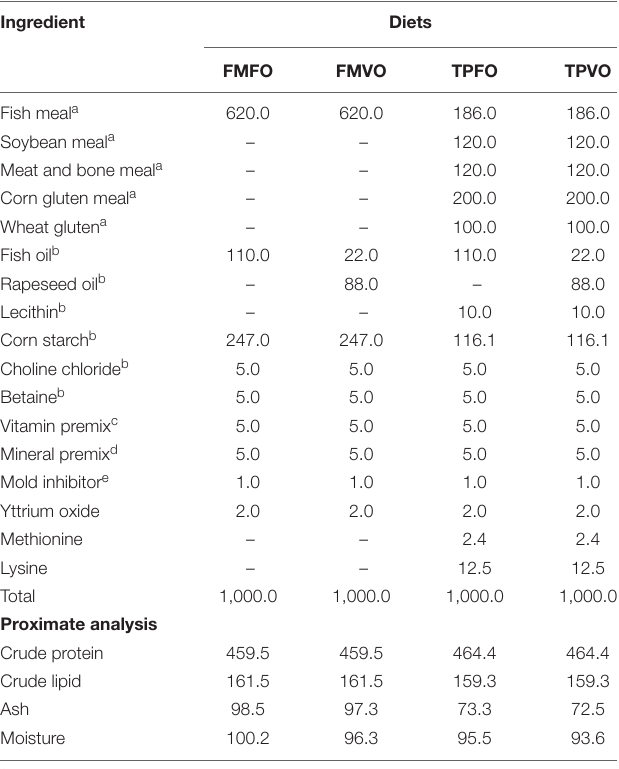
TABLE 1 | Ingredient and proximate composition of experimental diets (all values are